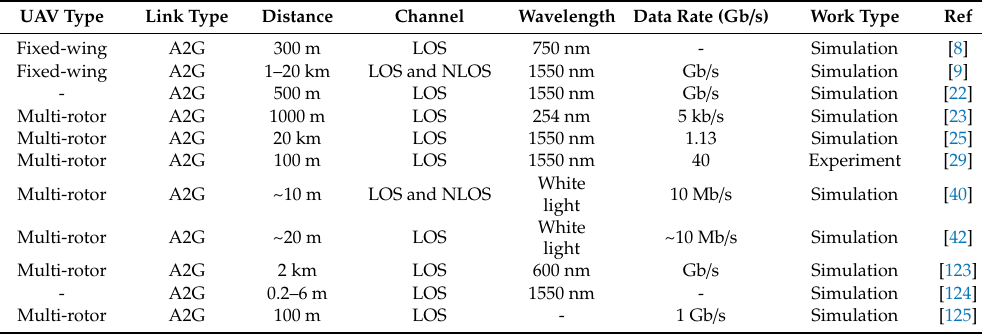
Table 4. Comparison of performance and parameters for UAV airborne optical wireless